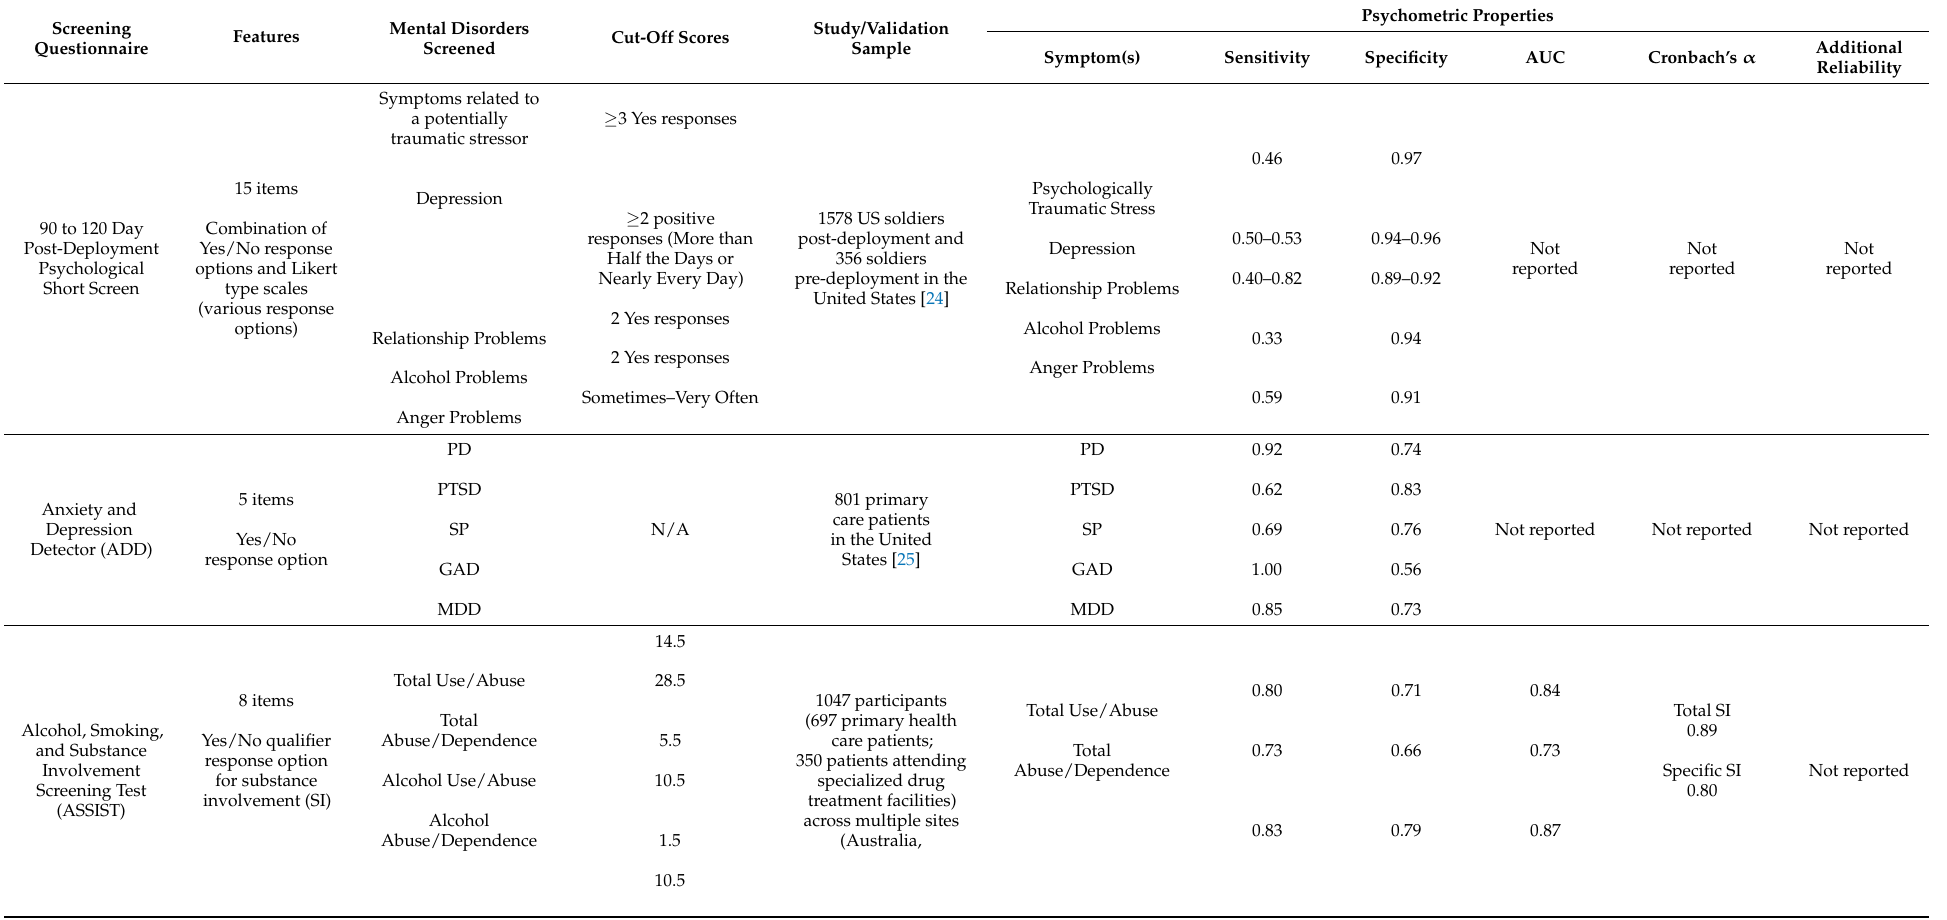
Table 1. Features and Empirical Evidence of Brief Mental Disorder Screening Questionnaires (Multiple Disorder Symptom